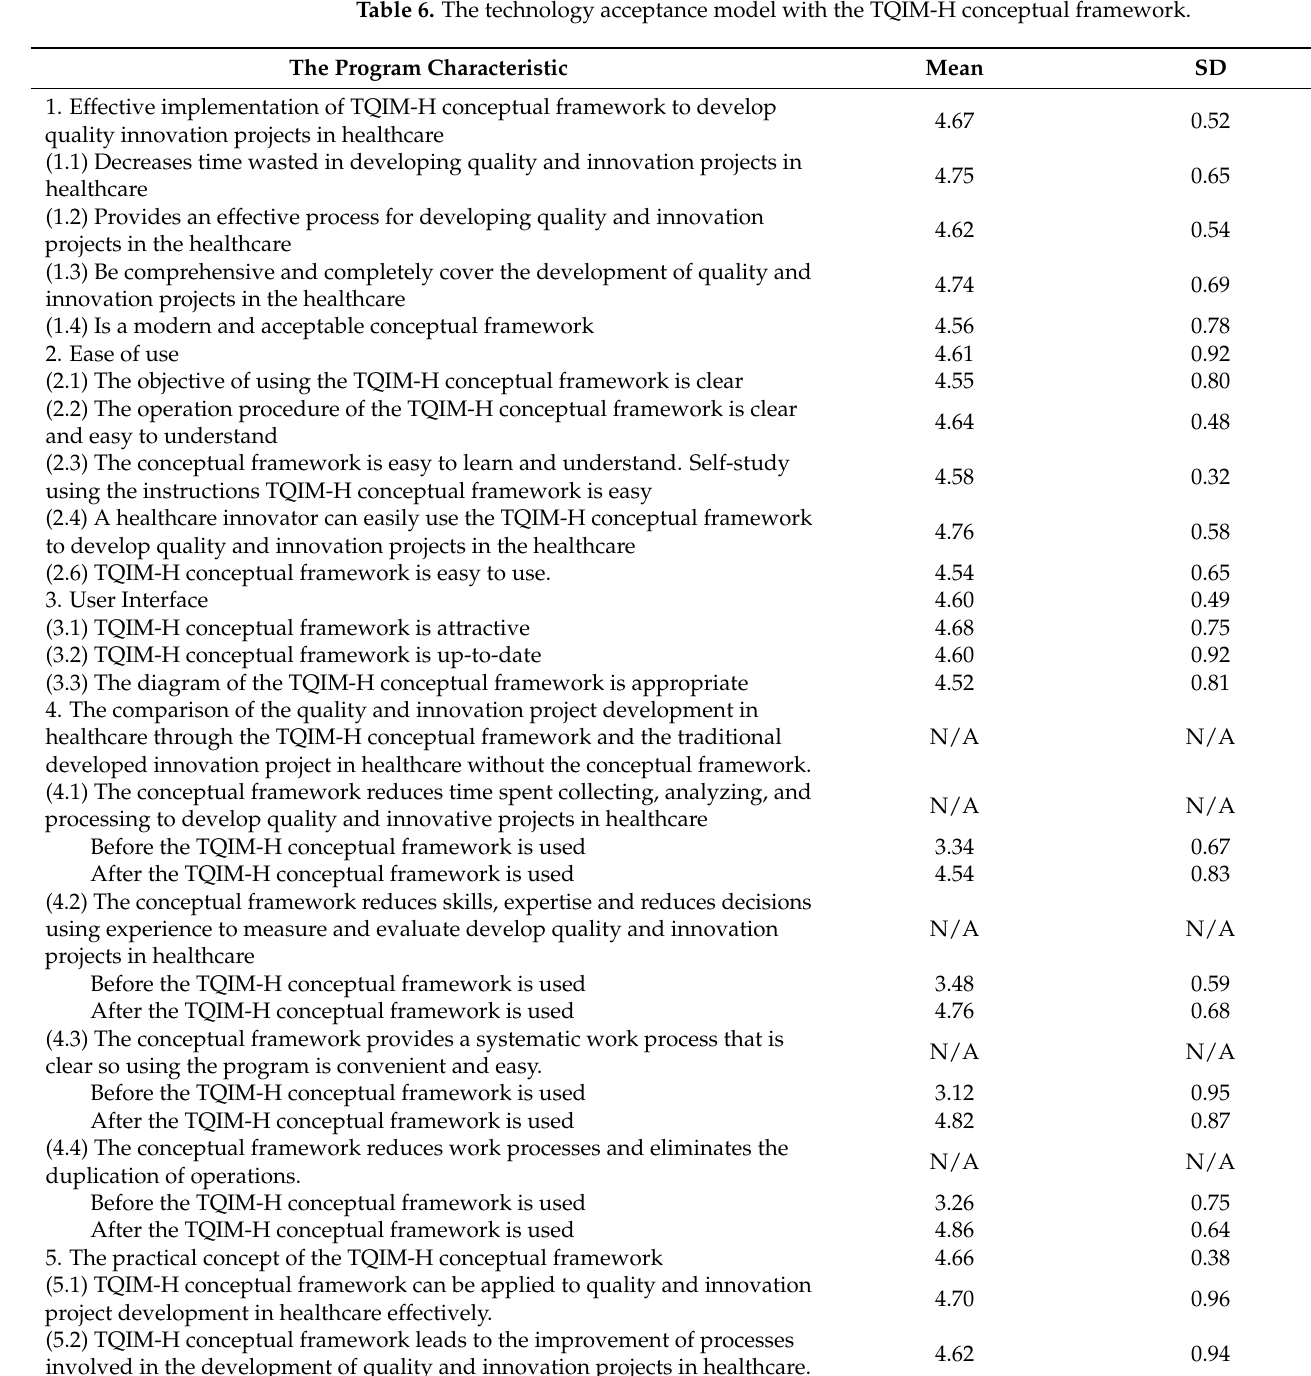
Table 6. The technology acceptance model with the TQIM-H conceptual